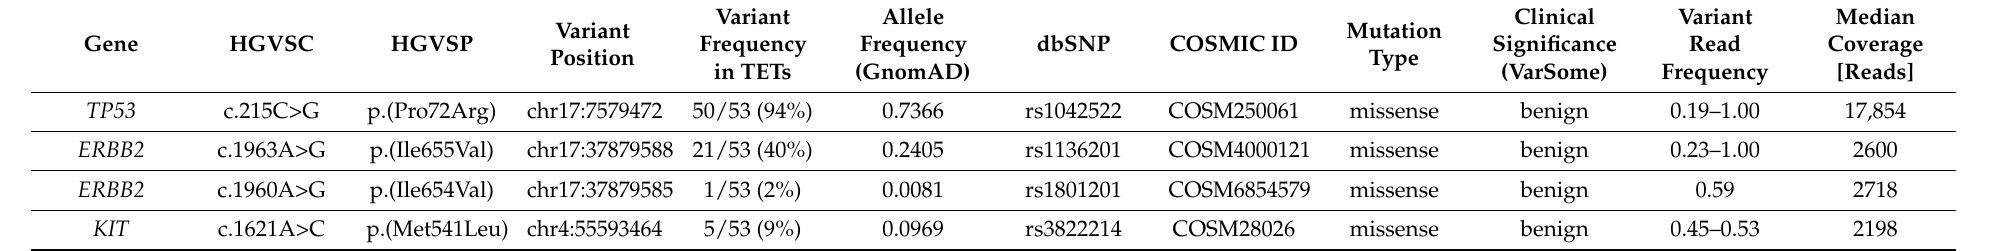
Table 3. The summary of single nucleotide variants, which clinical significance is considered as benign, identified in thymic epithelial